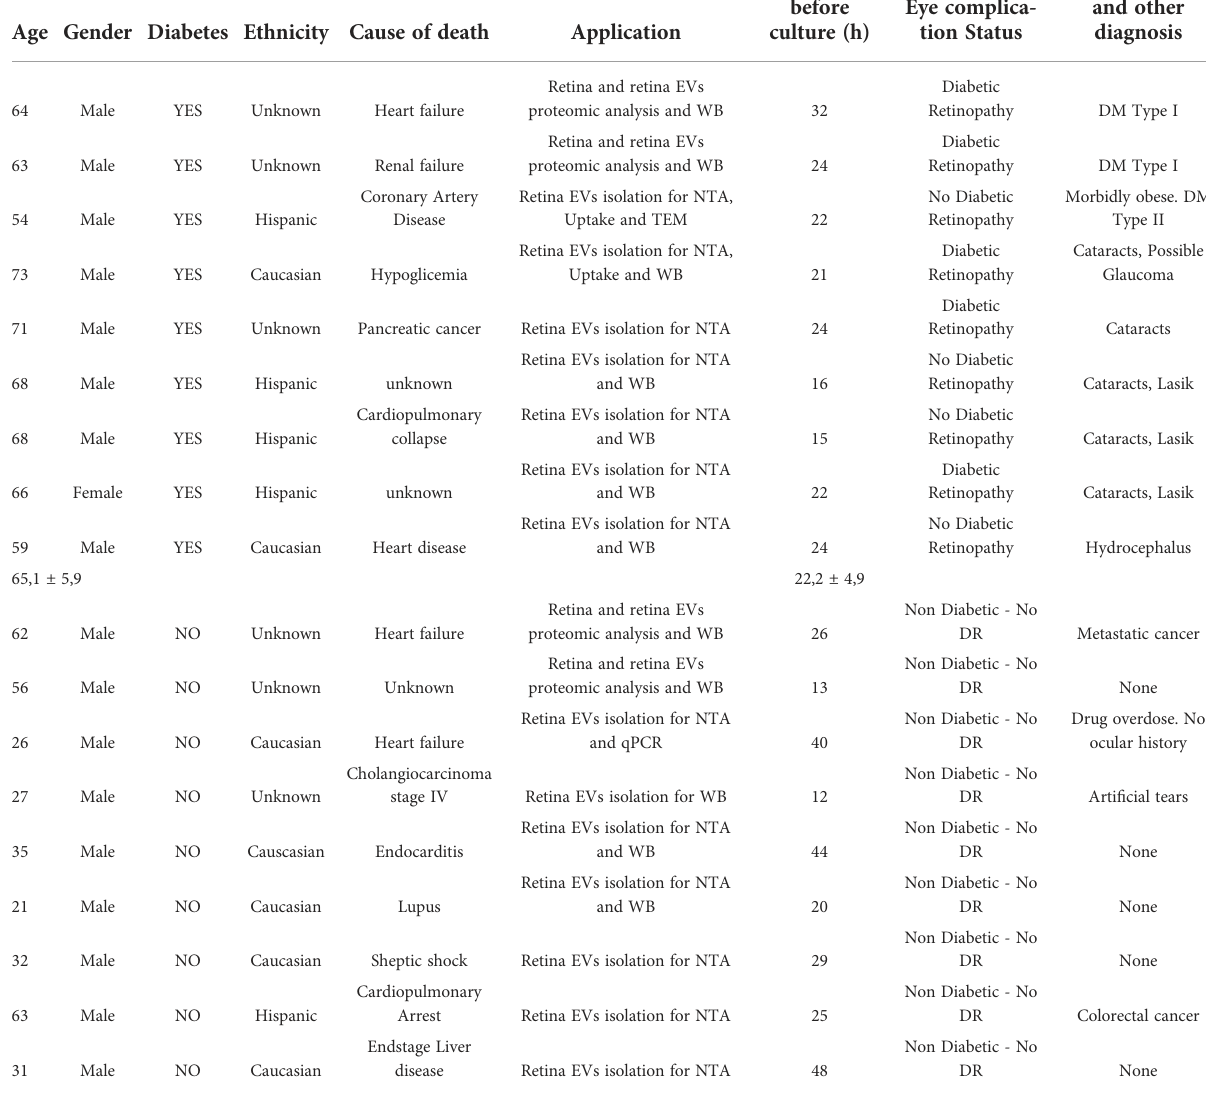
Age Gender Diabetes Ethnicity Cause of